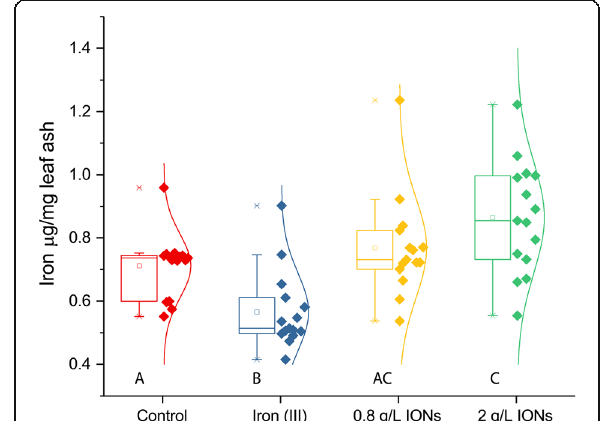
Fig. 7 Iron concentration in brassica plant leaves after treatment with maghemite nanoparticles, as compared to control with same nutrient solution or the same nutrient solution with 1:1 M ratio of iron (III) ions. Different letters signify statistically significant